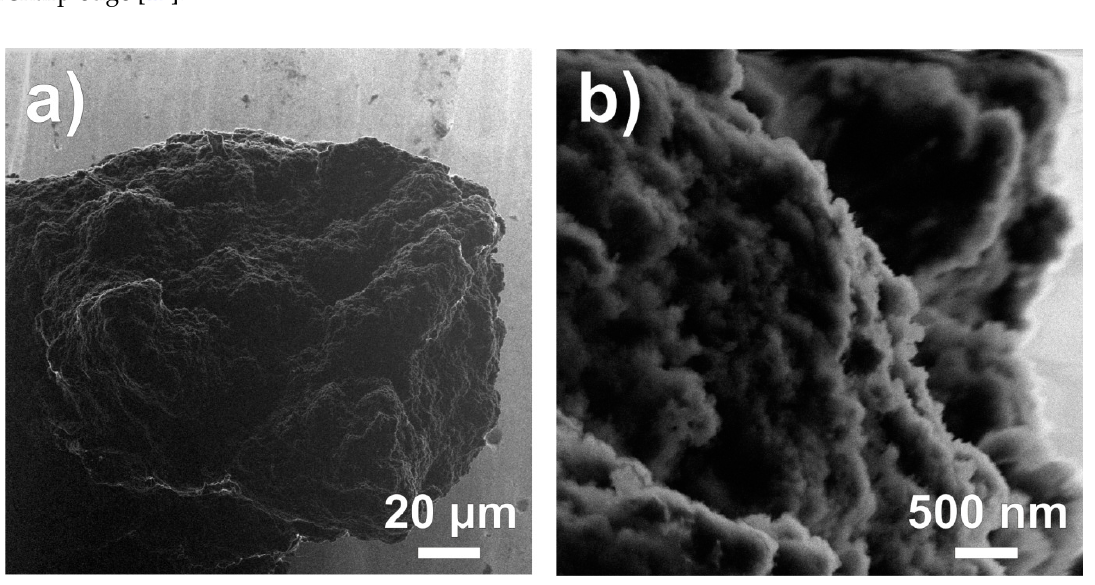
Figure 1. Helium-ion microscopy images of carbon nanofoam, ( a ) showing a micron-sized part of the foam and ( b ) showing in higher magnification the sponge-like surface of the foam.